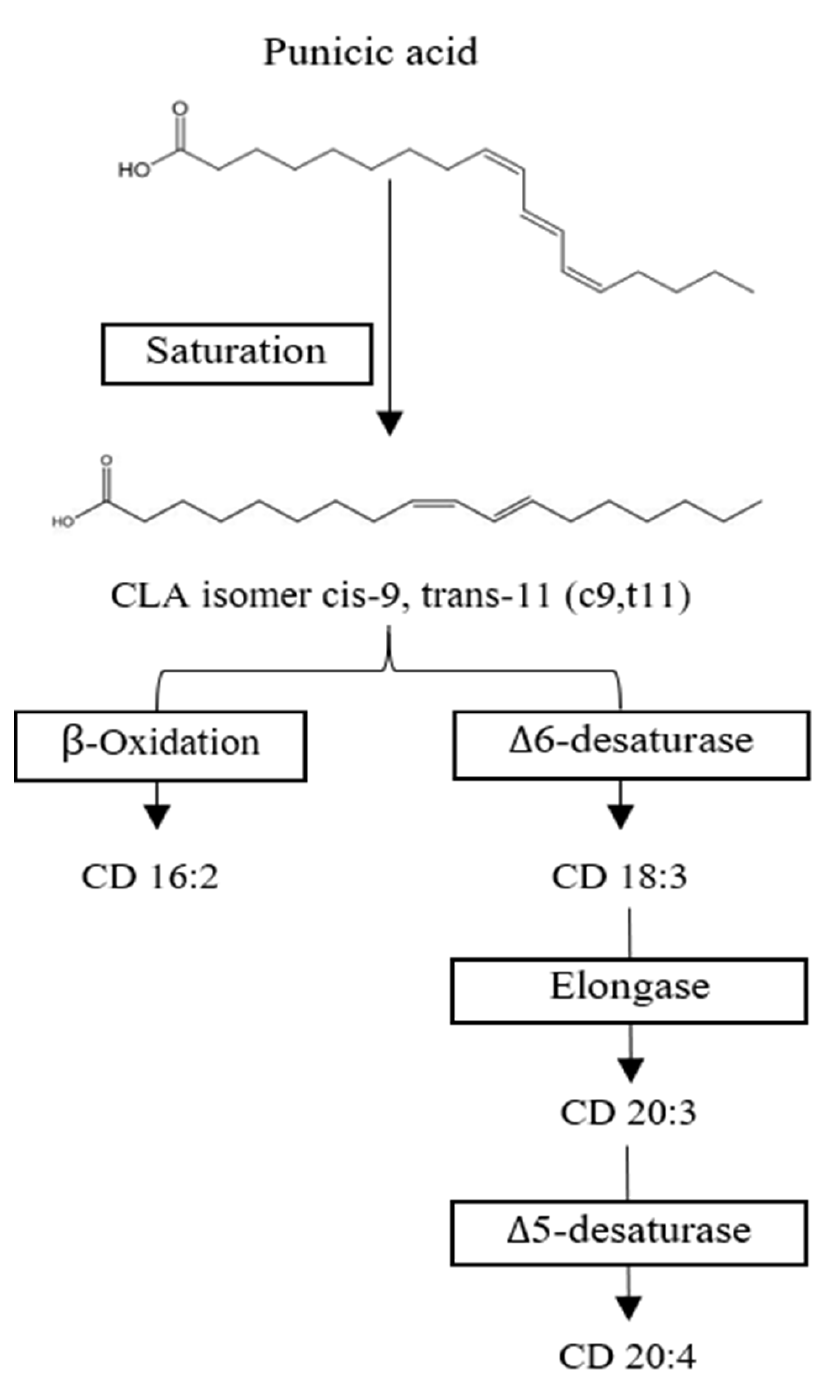
Figure 5. Proposed punicic acid metabolism. Punicic acid is transformed into conjugated linoleic acid (CLA cis-9, trans-11) and then either β -oxidized into Conjugated Diane (CD) 16:2 or metabolized by ∆ 6-desaturase to become CD 18:3 to be further processed into CD 20:3 and CD 20:4. Chemical structures drawn in ChemDraw.